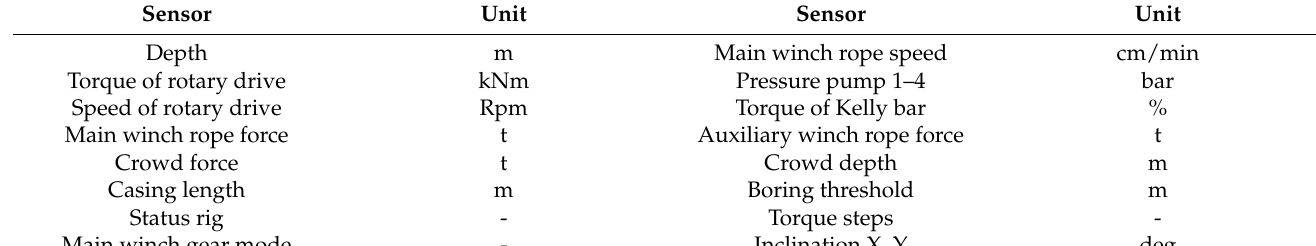
Table 1. Sensor data available from the Kelly drill rig.